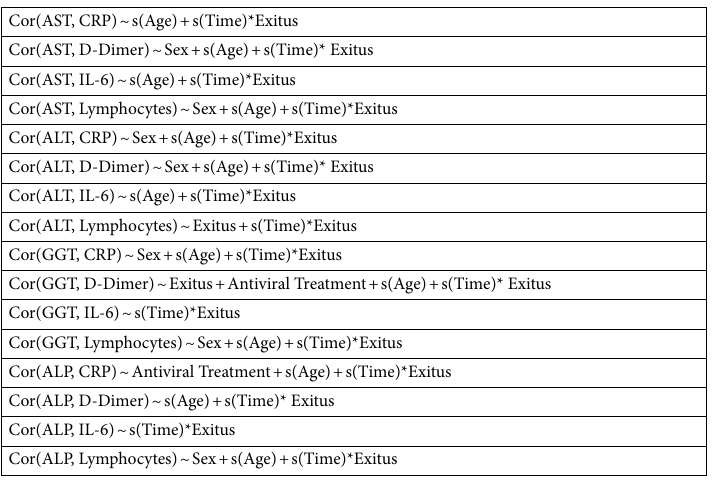
Table 4. Regression models for correlation between weighted and Box–Cox-transformed values of transaminases and weighted and/or Box–Cox-transformed (if required) inflammation markers (†). s() indicates the smooth effect of the covariate. * indicates association. For sex, the reference level is “Male”. For Exitus, the reference level is “Living”. For antiviral treatment, the reference level is “No”. The centered smooth effects of s(Time) and s(Age) in the correlation are depicted in Figs. 3 and 4, respectively. (†): From the general model type 2 every regression model in this table only includes the covariates that were found to be statistically significant ( p <